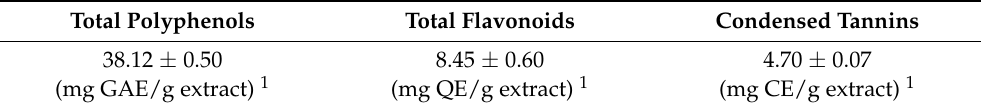
Table 1. Spectrophotometric quantitative determination of total polyphenols, flavonoids, and con- densed tannins in B. raimondoi leaf extract. Total Polyphenols Total Flavonoids